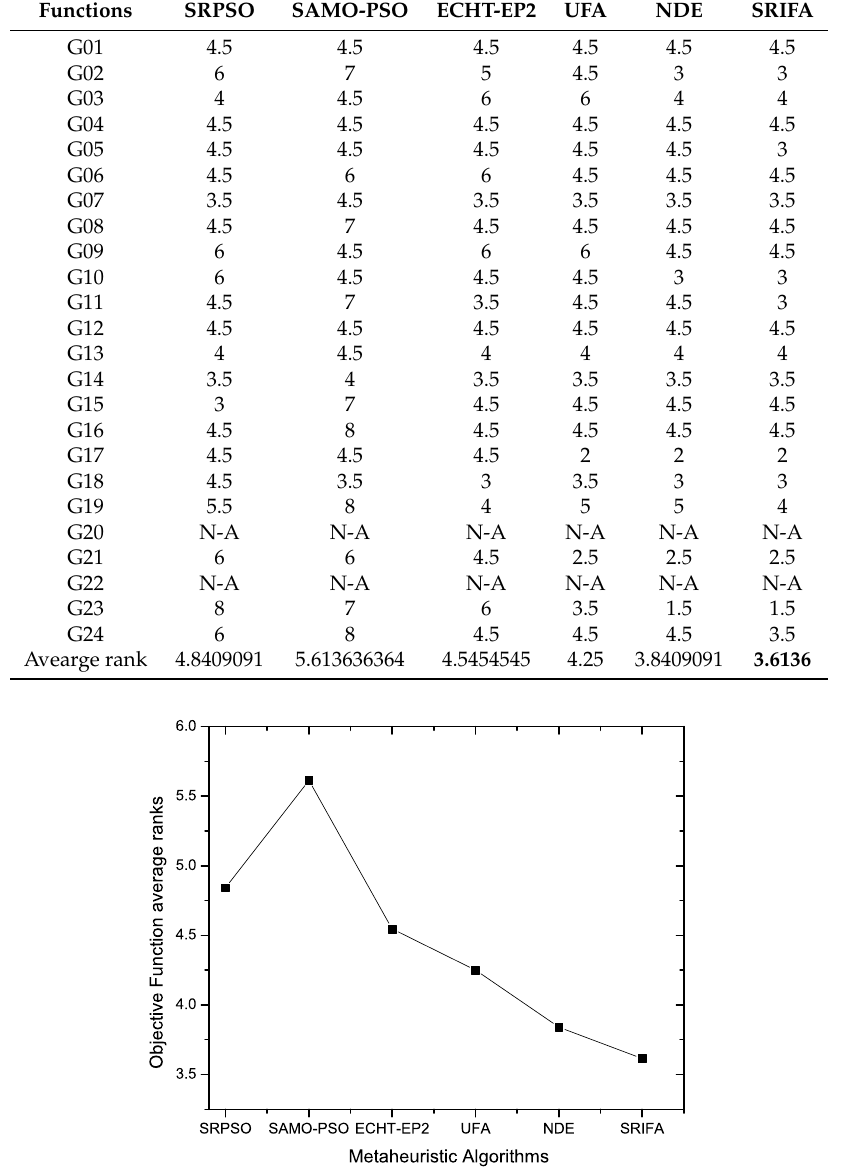
Figure 5. Average ranking of the proposed algorithm with various metaheuristic